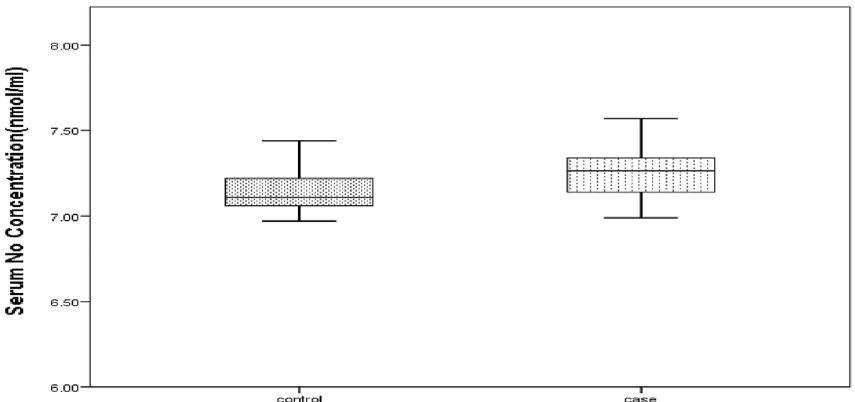
Figure 2. Box plot of serum NO level distribution in the case and control groups with thyroid disorders.